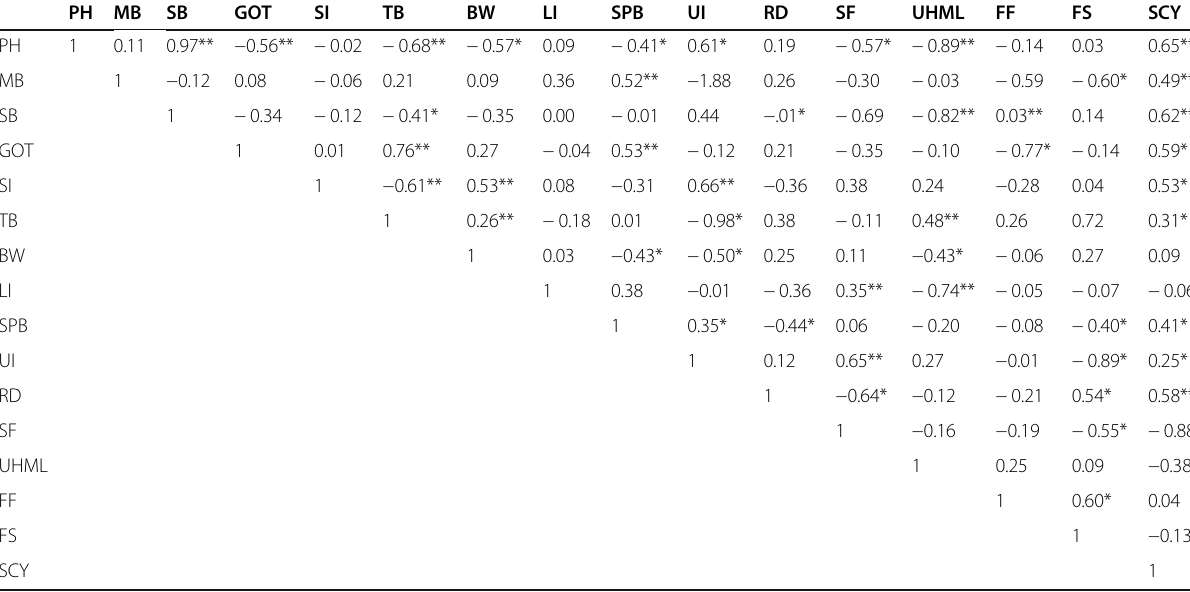
Table 5 Genotypic correlation coefficient for yield and fiber traits in upland